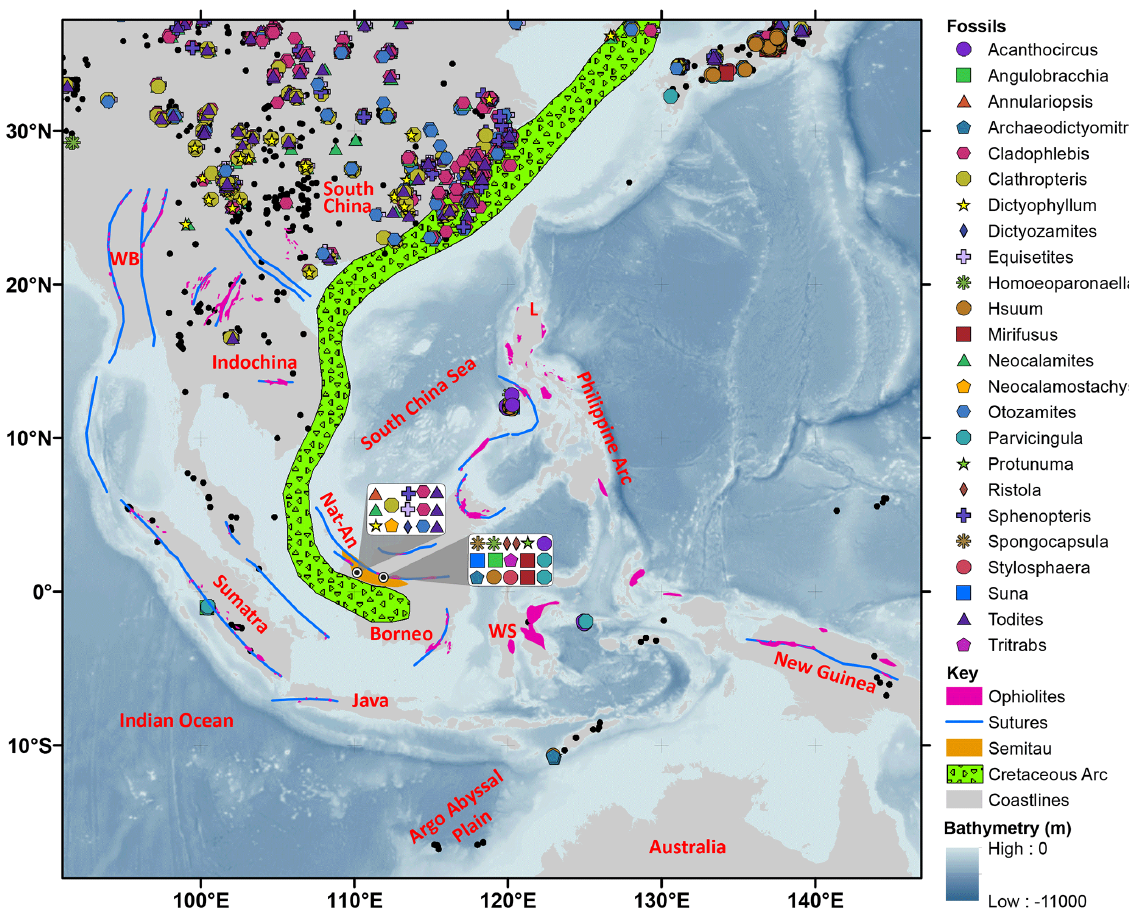
Fig. 6. Triassic and Jurassic fossil occurrences from the global Paleobiology Database (now Fossilworks), representing 24 fossil genera (30 samples from two locations), are found on Borneo within the Semitau continental block (orange). The paleobiological affinity between South China and this part of Borneo is significant during this time, suggesting that the Semitau continental fragment likely originated on the South China margin. The Natuna–Anambas Arc across central present-day Borneo represents the westward-dipping subduction zone that consumed the proto-Pacific, likely linked the east Asian volcanic arc (including the Fukien–Reinan Massif, modified from Honza and Fujioka, 2004) with the Schwaner Mountain granitoids in southwest Borneo. The age of the volcanics are at least Middle Jurassic, and likely indicate that the southwest Borneo core was part of Sundaland since at least the Middle Jurassic, and was unlikely a latest Jurassic Gondwanan allochthon. Although sampling of Indochina may be lower than of South China, the fossil occurrences do not indicate tectonic affinity between Indochina and Semitau (Borneo) during the Triassic and Jurassic. Paleobiological data from the global Paleobiology Database suggest that the Semitau block was along the South China mainland during the Triassic and Jurassic, and we interpret that it was rifted from this margin in the latest Cretaceous–early Eocene to open the proto-South China Sea in a back-arc setting. Nat-An–Natuna–Anambas Arc, WB–West Burma, WS–West